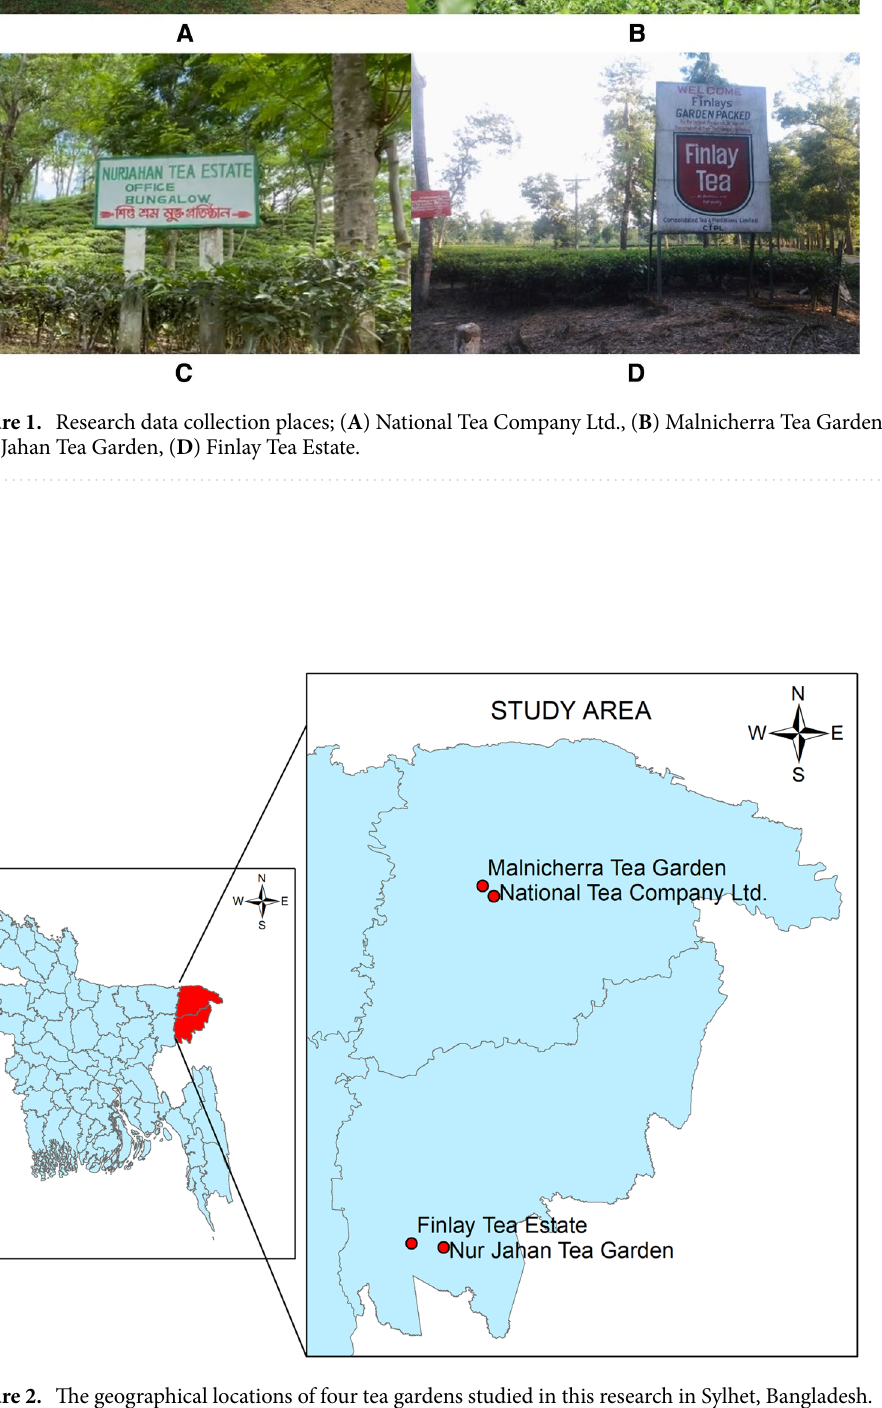
Figure 2. The geographical locations of four tea gardens studied in this research in Sylhet,